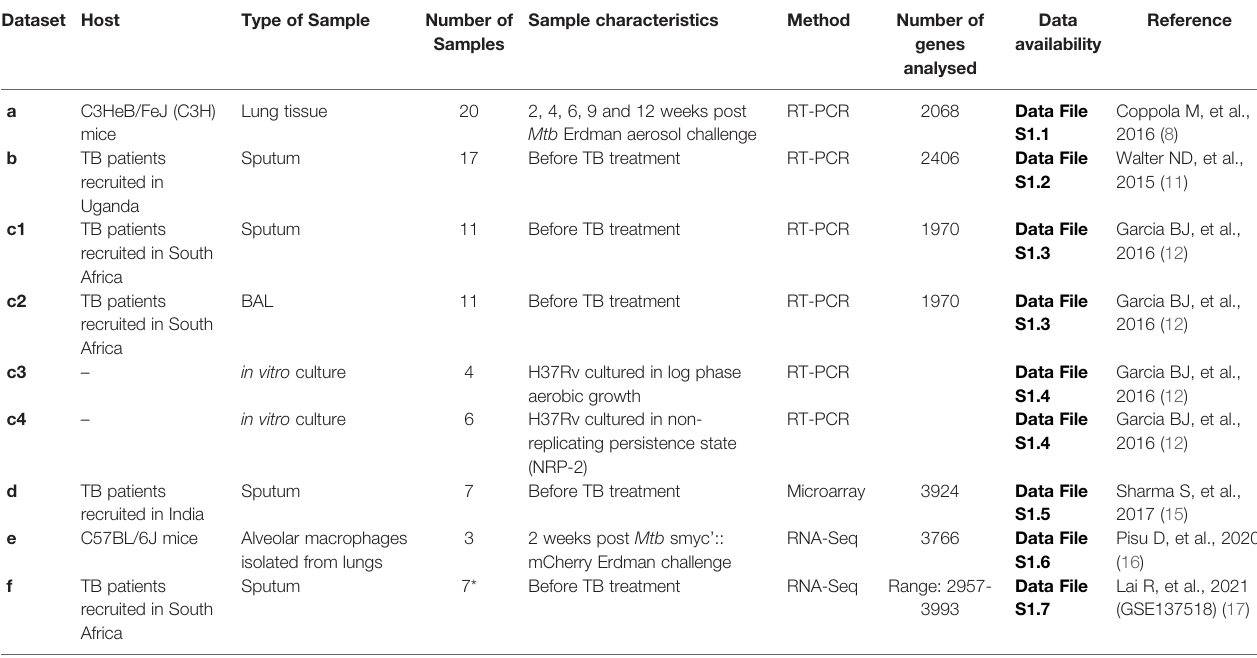
TABLE 1 | Description of the Mtb transcriptomic datasets included in the